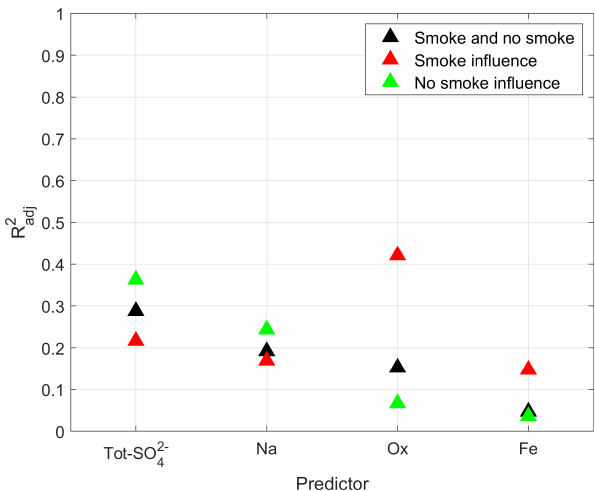
Figure 7. Effect of the influence of smoke on the ability of a single species to predict N d